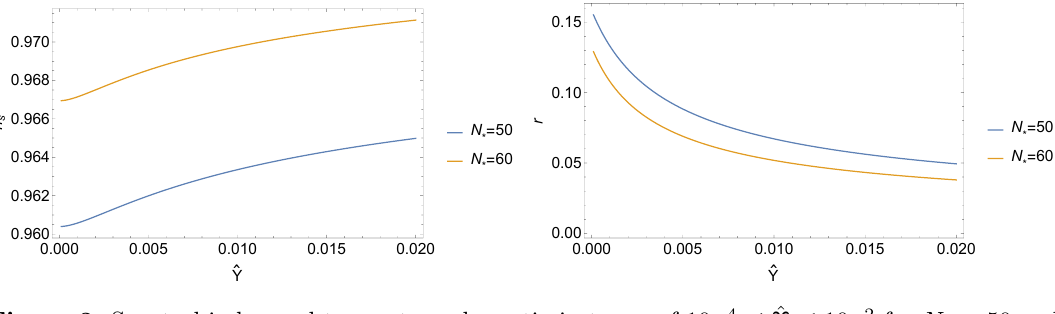
Figure 3 . Spectral index and tensor-to-scalar ratio in terms of 10 (cid:0) 4 6 ^(cid:7) 6 10 (cid:0) 2 for N (cid:3) = 50 and N (cid:3) = 60